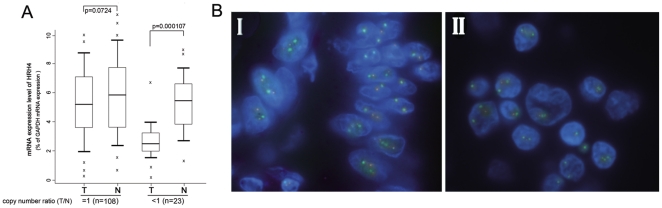
Copy number loss of HRH4 in GCs.(A) Real-time PCR assay was carried out as described under Materials and Methods section, and the results were obtained from indicated group of samples. Boxplots of relative copy number of HRH4 mRNA measured with Real-Time PCR analysis showing median; box: 25th–75th percentile; bars: largest and smallest values within 1.5 box lengths; little cross: outliers. mRNA expression level of HRH4 in groups with deleted (n = 23) or unaltered (n = 108) DNA copies. (B) Representative figure of FISH analysis using chromosome 18q specific alpha satellite DNA probe and chromosome 18q11 specific probe for HRH4 gene. I. Nucleus of ANT tissue with two signals for each of green and orange, showing no deletion of chromosome 18q or HRH4 gene. II. Nucleus of GC tissue with 0–2 signals for green and 0–2 signals for orange, indicating relative deletion in chromosome 18q or HRH4 gene.